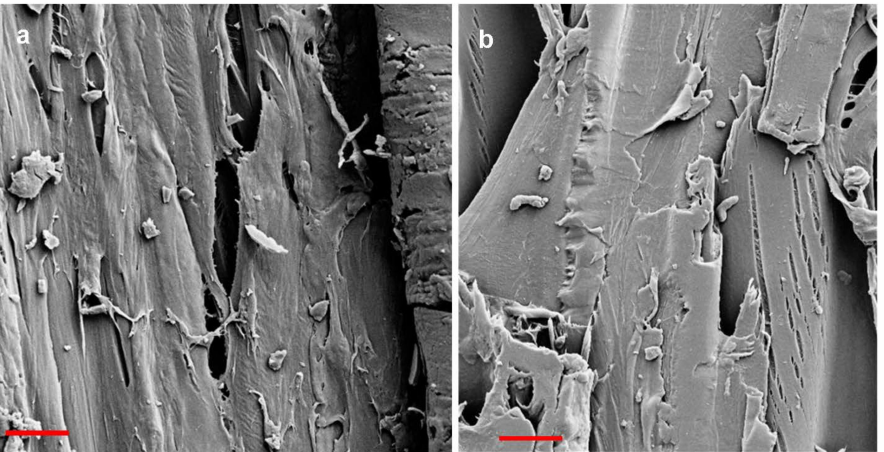
Figure 7. SEM images of inside stored B30 ( a ) and LS30 ( b ) surfaces showing both shrinkage and rupture. Bar = 10 µ